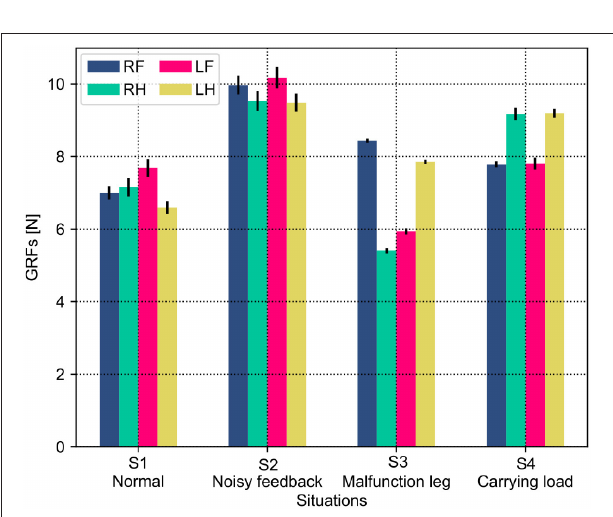
FIGURE 10 | GRF distribution of the self-organized robot locomotion under the PM in four situations. Note that RF, RH, LF, and LH indicate the right front, right hind, left front, and left hind legs, respectively.